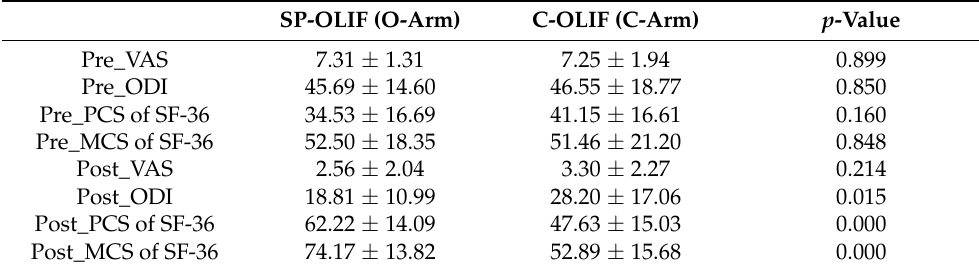
Table 5. Clinical outcomes.